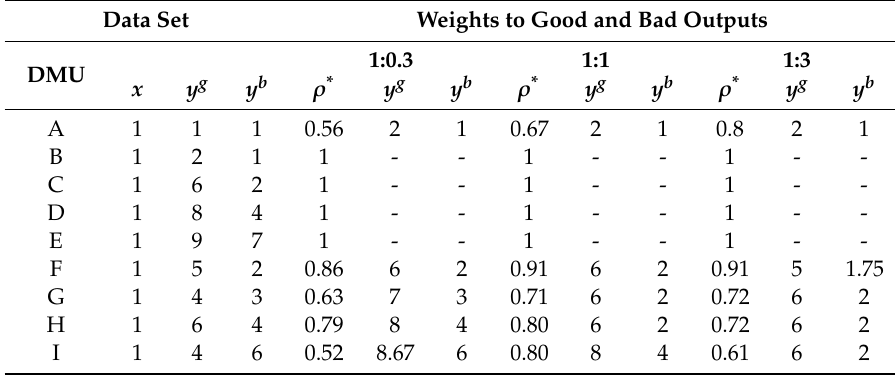
Table 1. Data set with undesirable output and weight e ff ects in the Slack Based Measurement. Data Set Weights to Good and Bad Outputs DMU